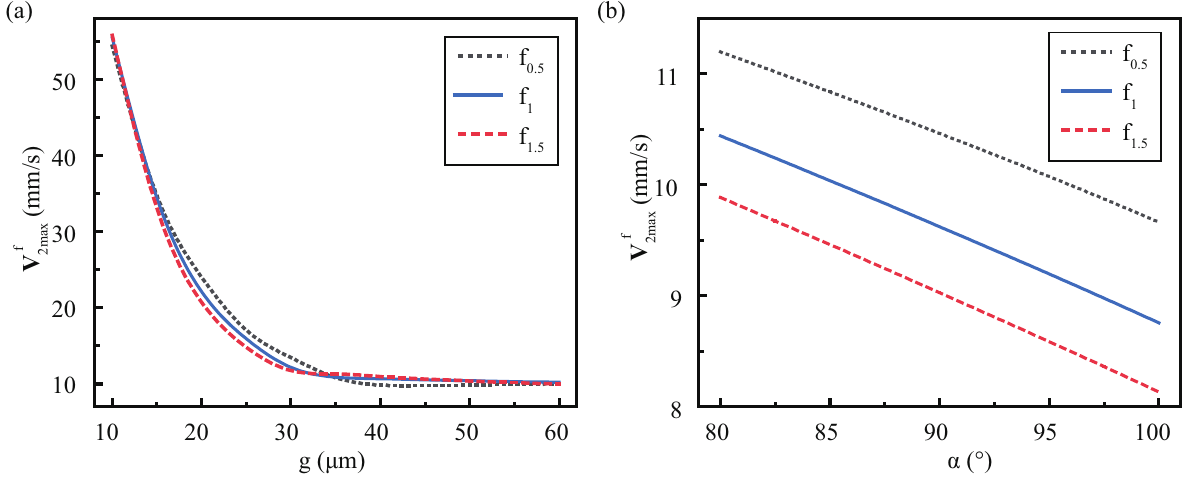
Figure A5. The effect on frequency equivalent velocity by side profile parameters: ( a ) gap g and ( b ) sidewall angle α